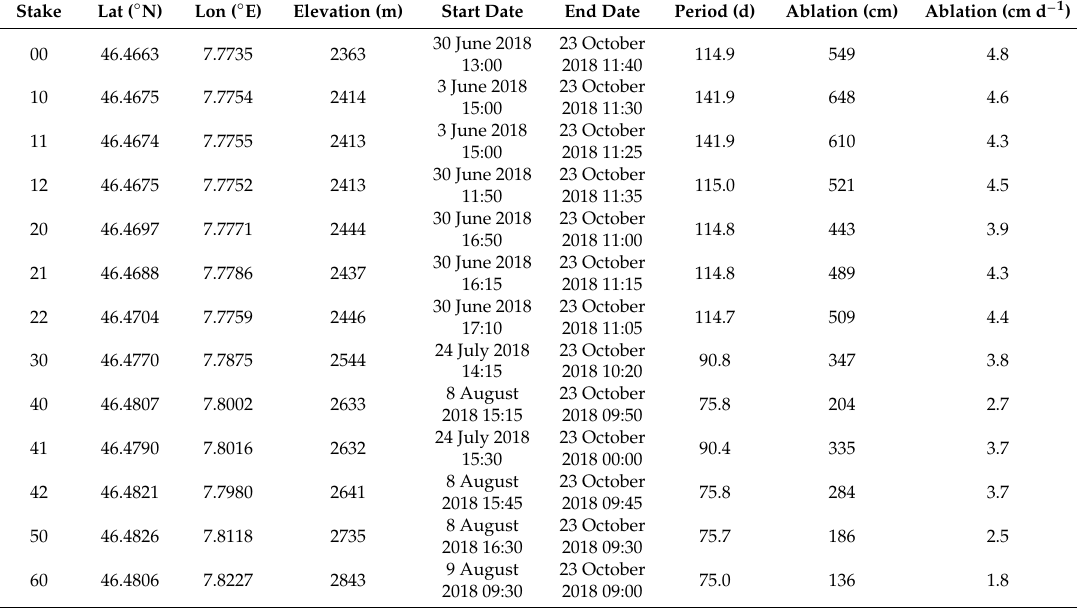
Table 2. Overview of the ablation measurements at the Kanderfirn between June and October 2018. Stake Lat ( ◦ N) Lon ( ◦ E) Elevation (m) Start Date Period (d) Ablation (cm d − 1